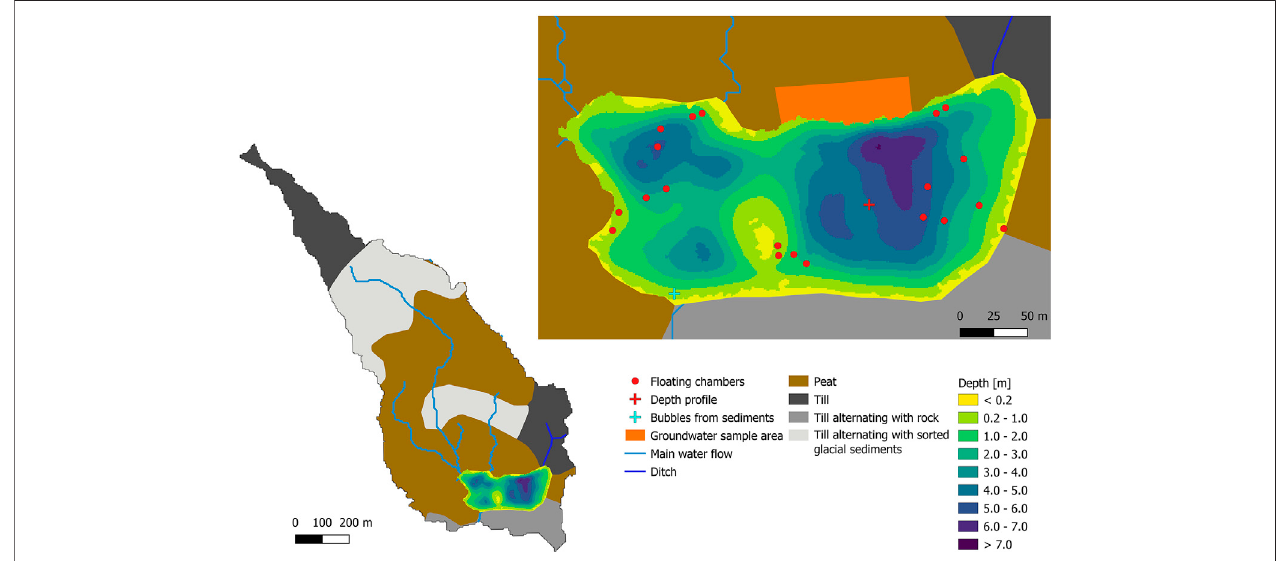
FIGURE 2 | Left: Types of soil and theoretical water fl ow direction in the catchment of Stortjärn. The outlet of the lake is located at the southwestern shore. The water fl owdirectioninthemireonthenorthwesternsideofthelakeiscalculatedbasedontheDEMofthecatchment.Asmallditchforms asmallinlet inthenortheastern corner of the lake. Right: Bathymetric map of the lake with locations where groundwater, water column depth pro fi les and bubbles in littoral sediments were sampled, and positions of the fl oating chambers used to measure CH 4 fl uxes at the surface of the lake. © Lantmäteriet, i2012/901.